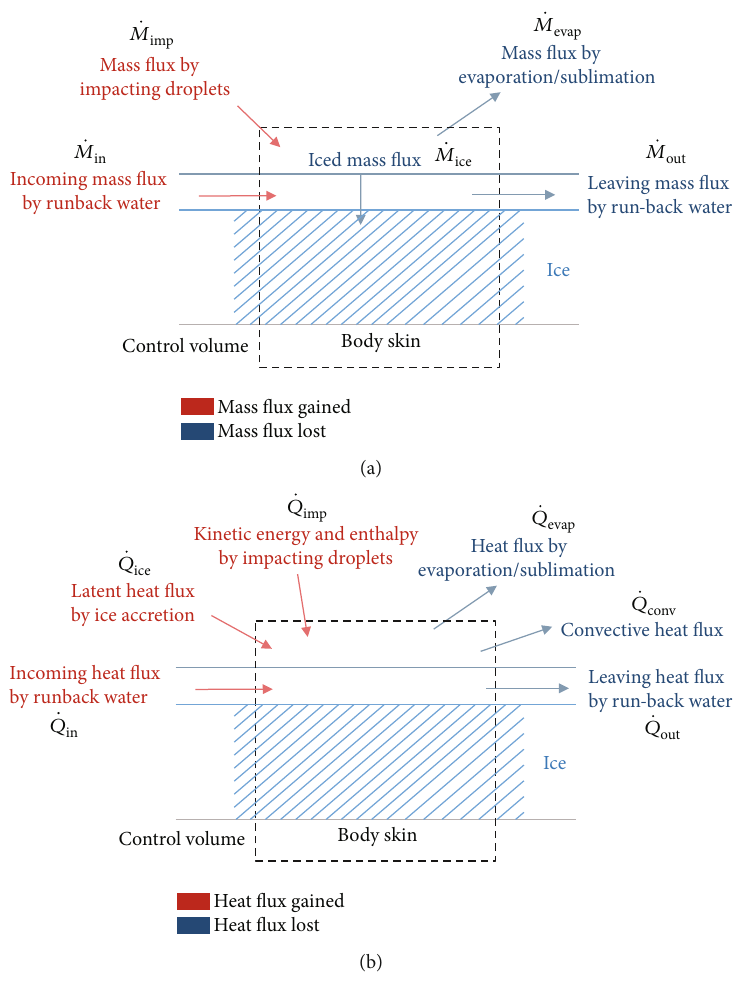
Figure 2: Mass (a) and energy (b) balance of a control volume during in- fl ight ice accretion.